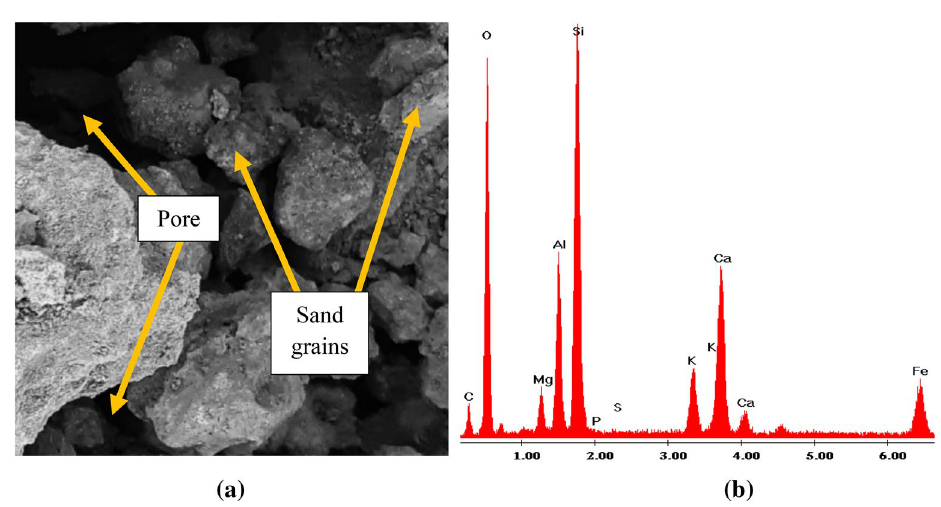
Figure 2. SEM micrograph and EDX of sand employed in the